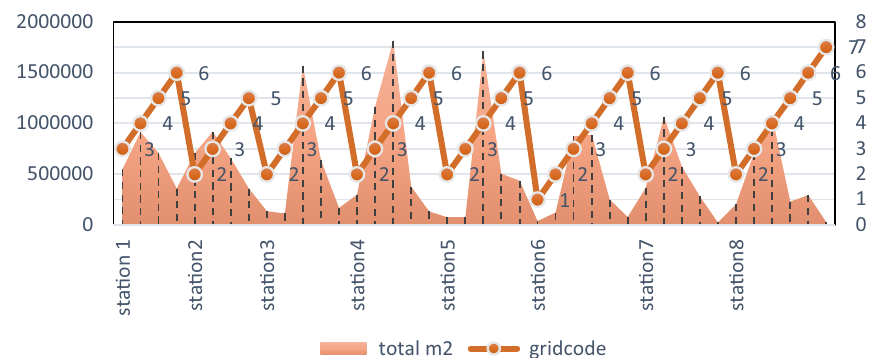
Fig. 9 Area (m 2 ) and grid code values for buffer zones (1000 m)